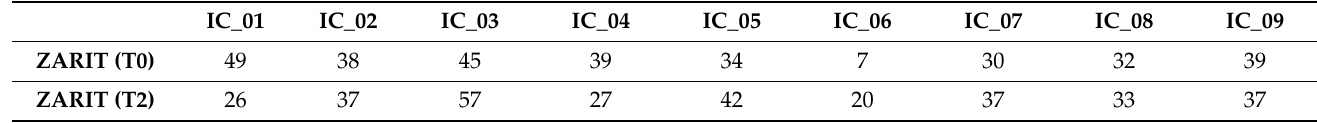
Table 5. ZARIT scores of informal caregivers at the beginning and at the end of the test.